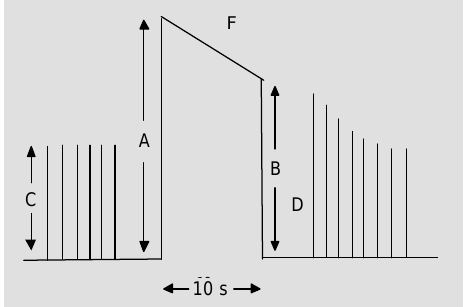
Figure 1- Examples of cat ante- rior tibial muscle contractile re- sponse during tetanic stimula- tion. The tetanic fade is calcu- lated as the ratio (R) between the tension at the end (B) and the tension at the beginning (A) of the tetanic response (R = B/ A). C and D correspond to pretetanic and post-tetanic twitches, respectively. F repre- sents the rate of stimulation re- quired to obtain R = 0.75.